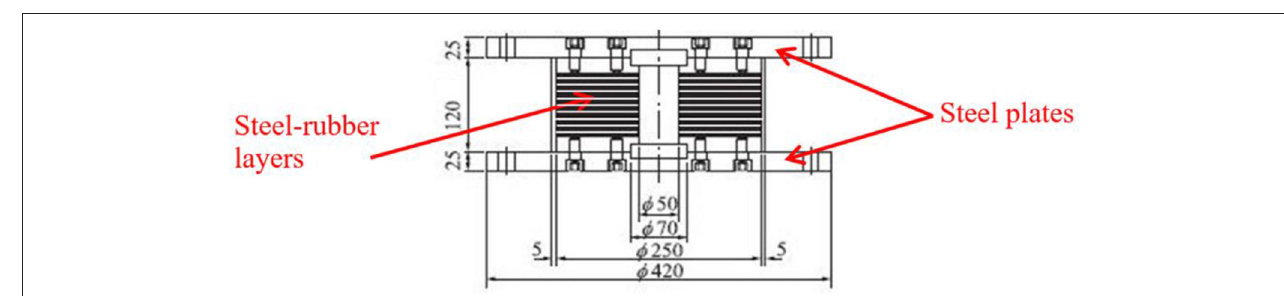
FIGURE 1 | The tested bearing